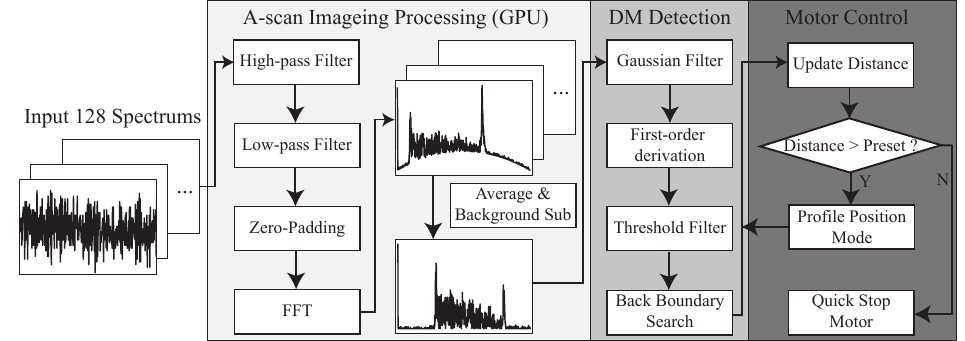
Figure 4. Data processing flowchart consisting of (1) OCT A-scan data processing, (2) DM detection, and (3) motor